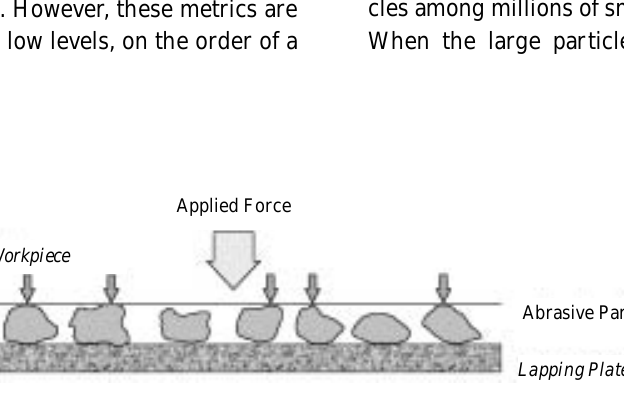
Schematic of graded particles in a lapping or polishing application showing how uniformly sized particles bear the